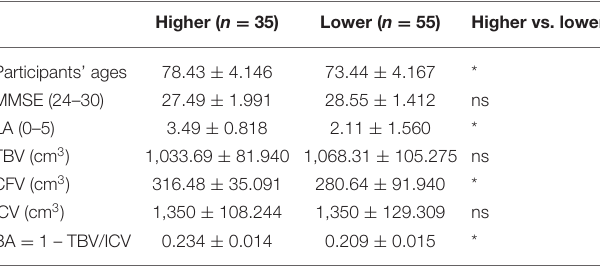
TABLE 1 | The profile of participants with higher and lower grades of aging brains.